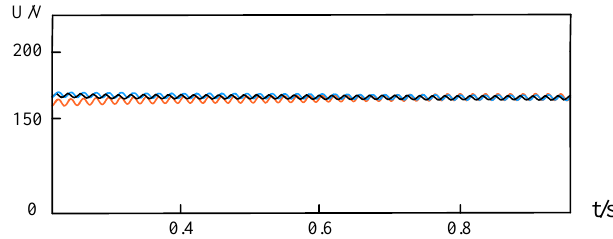
Figure 10. Current DQ decoupled double closed-loop control. ( a ) When the equivalent resistance on the DC side is inconsistent, the voltage cannot be balanced . ( b ) When the equivalent resistance on the DC side is consistent, the voltage can be balanced.